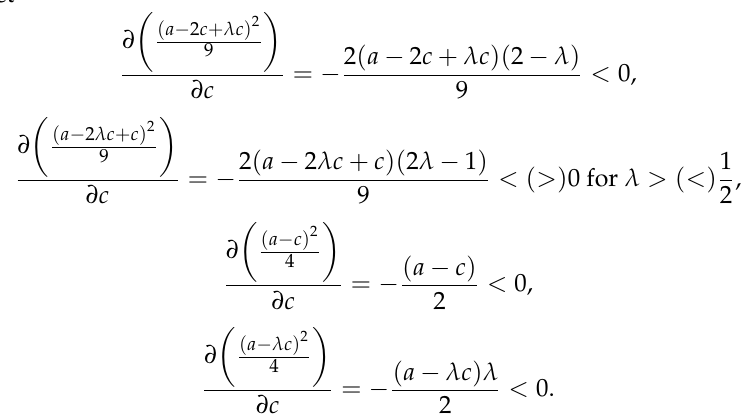
(cid:3028) or (cid:1855) > (cid:2873)